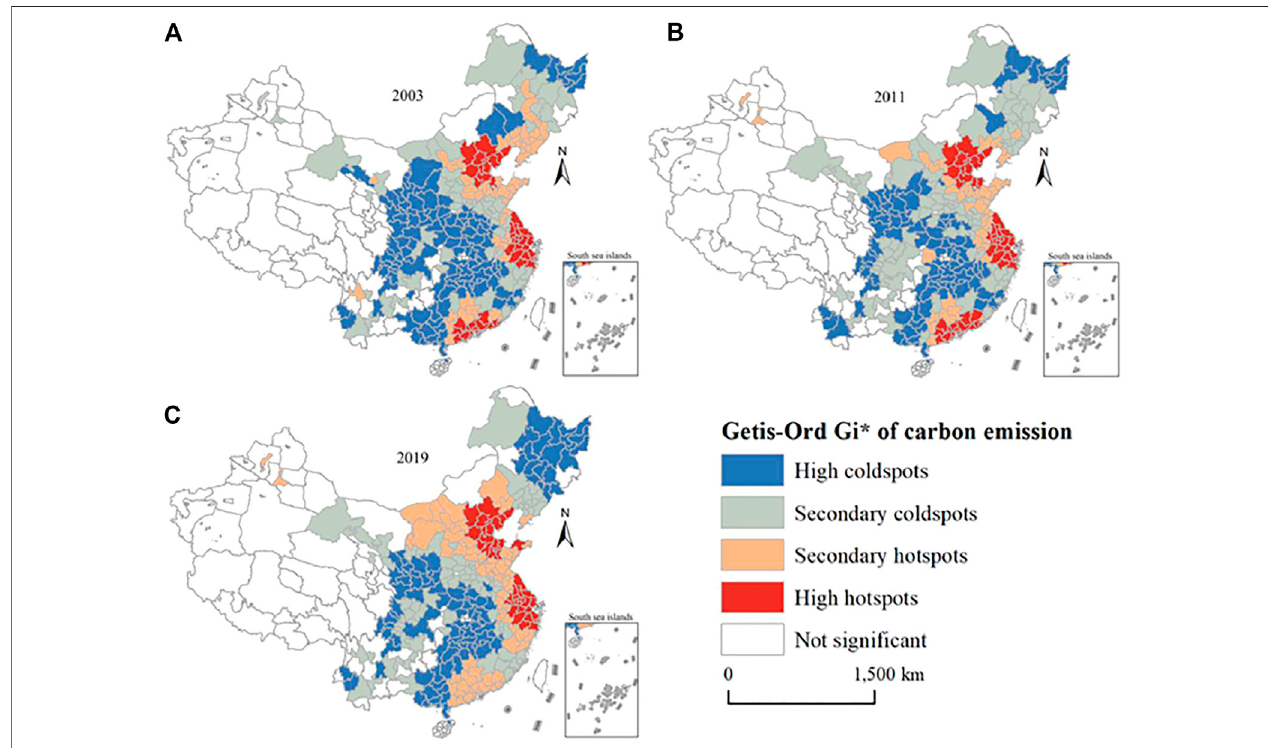
FIGURE 6 | Hot and cold spots of carbon emission in 2003, 2011, and